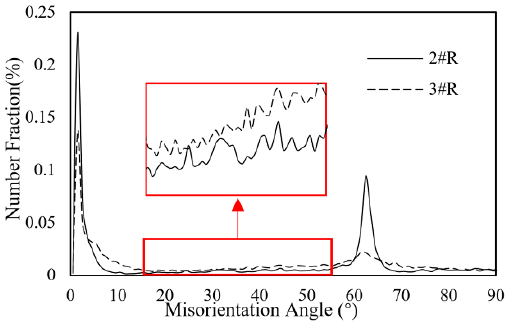
Figure 7. Misorientation angle distributions of Sample 2#R and Sample 3#R.